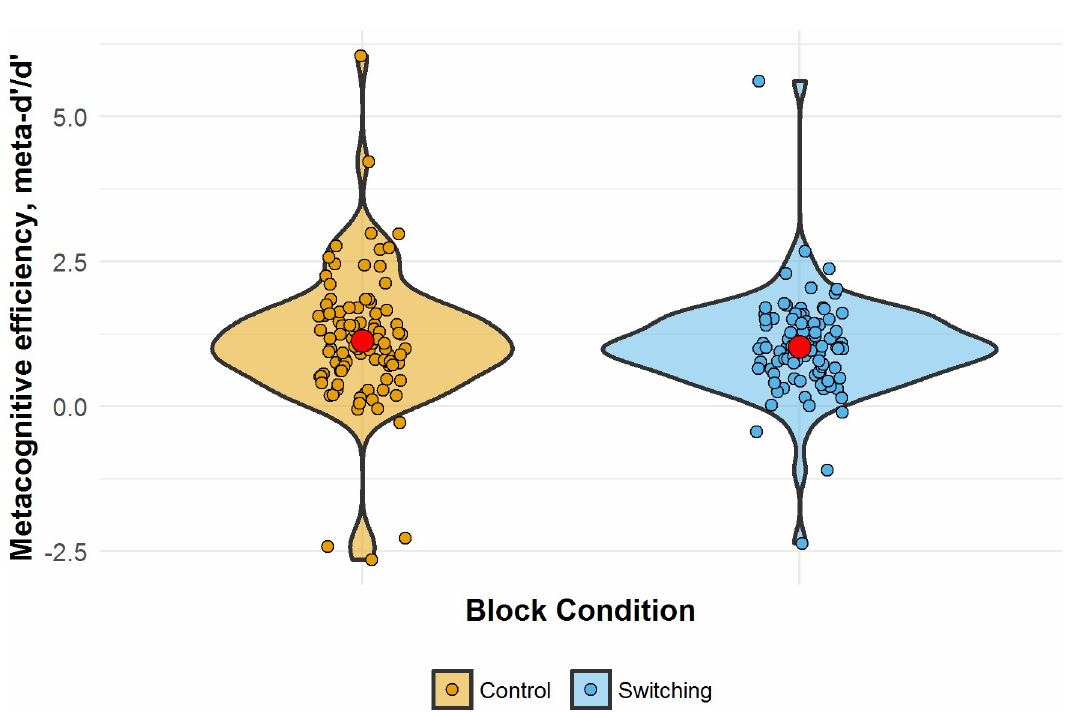
Fig 9. M-ratio (metacognitive efficiency) for the control and EF blocks. Red dots indicate the mean for each block.